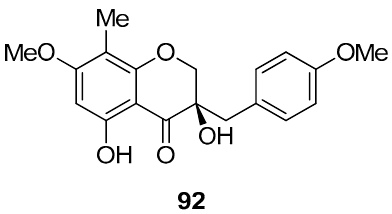
Molecules 2020 , 25 , x FOR PEER REVIEW Figure 14. Chemical structure of dracol isolated from D. draco. Figure 14. Chemical structure of dracol isolated from D. draco.